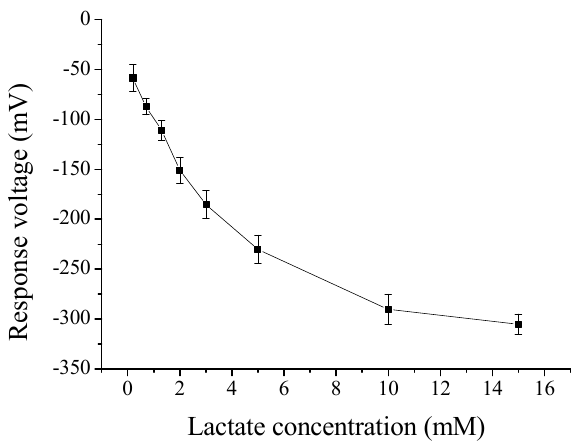
Figure 8. The detection of flexible arrayed lactate biosensor.